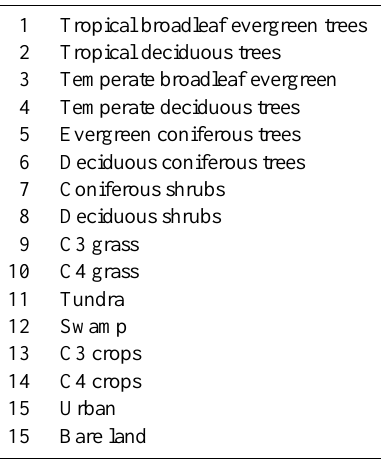
Table 1. Plant functional types incorporated in the